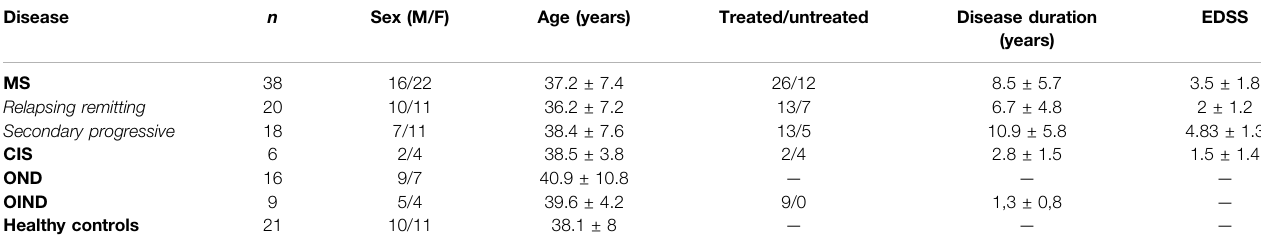
TABLE1| Characteristicsofmultiplesclerosis(MS)patientsandcontrols.GreekcohortofMSpatientsandcontrols. CIS :ClinicallyIsolatedSyndrome(3opticneuropathy,3 transverse myelitis). OND : Other Neurological Disorders (3 early-onset Alzheimer ’ s disease, 3 early-onset Parkinson ’ s disease, 2 motor neuron disease, 3 ischemic stroke, four epileptic seizures, one Vitamin B12 de fi ciency). OIND : Other In fl ammatory Neurological Disorders (2 limbic encephalopathy, fi ve acute lymphocytic meningitis, one lupus-associated myelopathy, one neuro-Behçet syndrome). Values are expressed as means ± SD. Disease